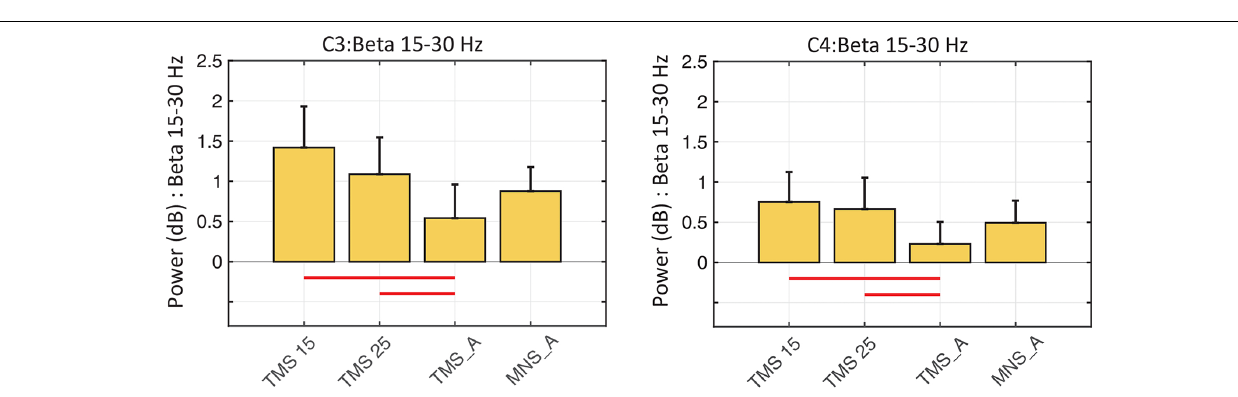
FIGURE 5 | Beta rebound statistics in C3 and C4 (mean ± SEM). The histograms show the beta power rebound in a 500-ms window (from 500 to 1,000 ms) across the four experimental conditions in the C3 (left panel) and C4 (right panel) electrodes. Red horizontal lines represent significant differences between conditions ( p < 0.05).